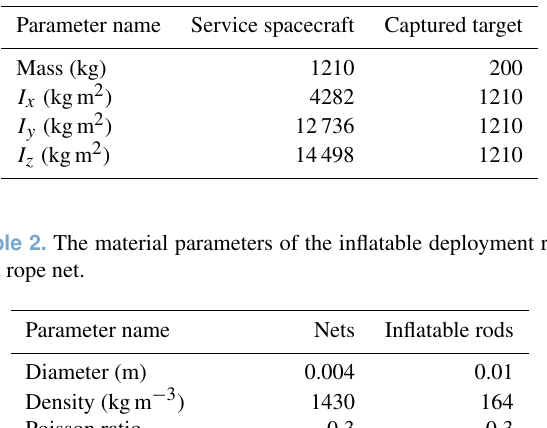
Table 1. The dynamic parameters of the service spacecraft and cap- tured target.